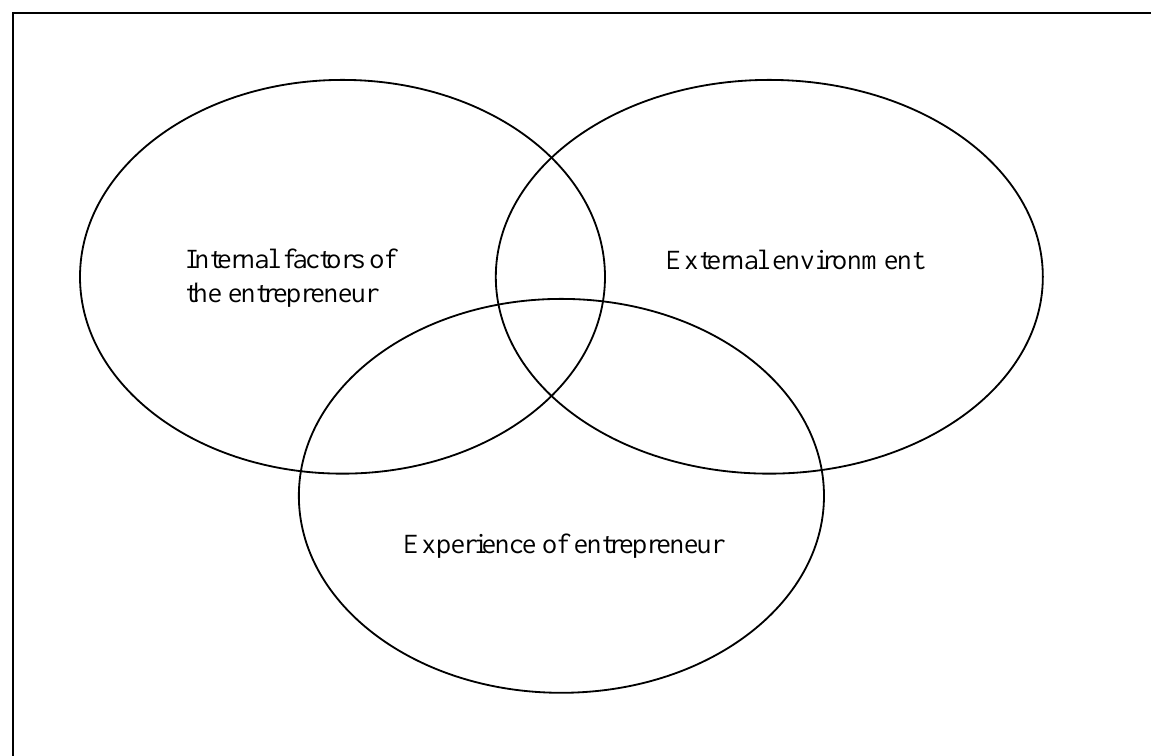
Figure 1: Entrepreneurial